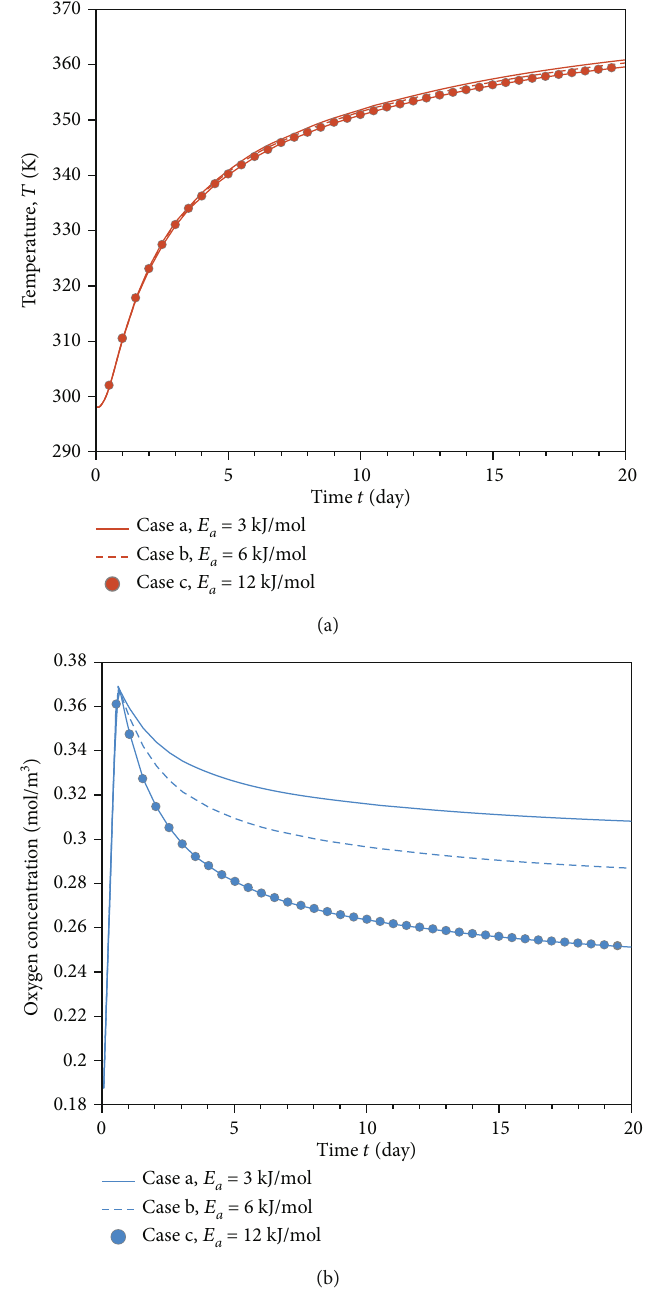
Figure 9: The evaluation of temperature and oxygen concentration with di ff erent values of activation